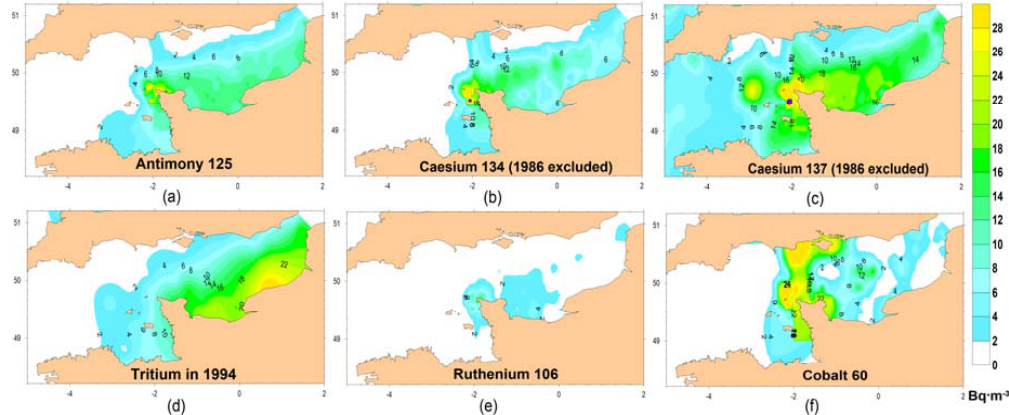
Figure 16. Average impact of the La Hague reprocessing plant in seawater corresponding to a constant release of 1 MBq · s − 1 ; ( a ) 125 Sb, ( b ) 134 Cs, ( c ) 137 Cs, ( d ) 3 H, ( e ) 106 Ru, ( f ) 60 Co, adapted from